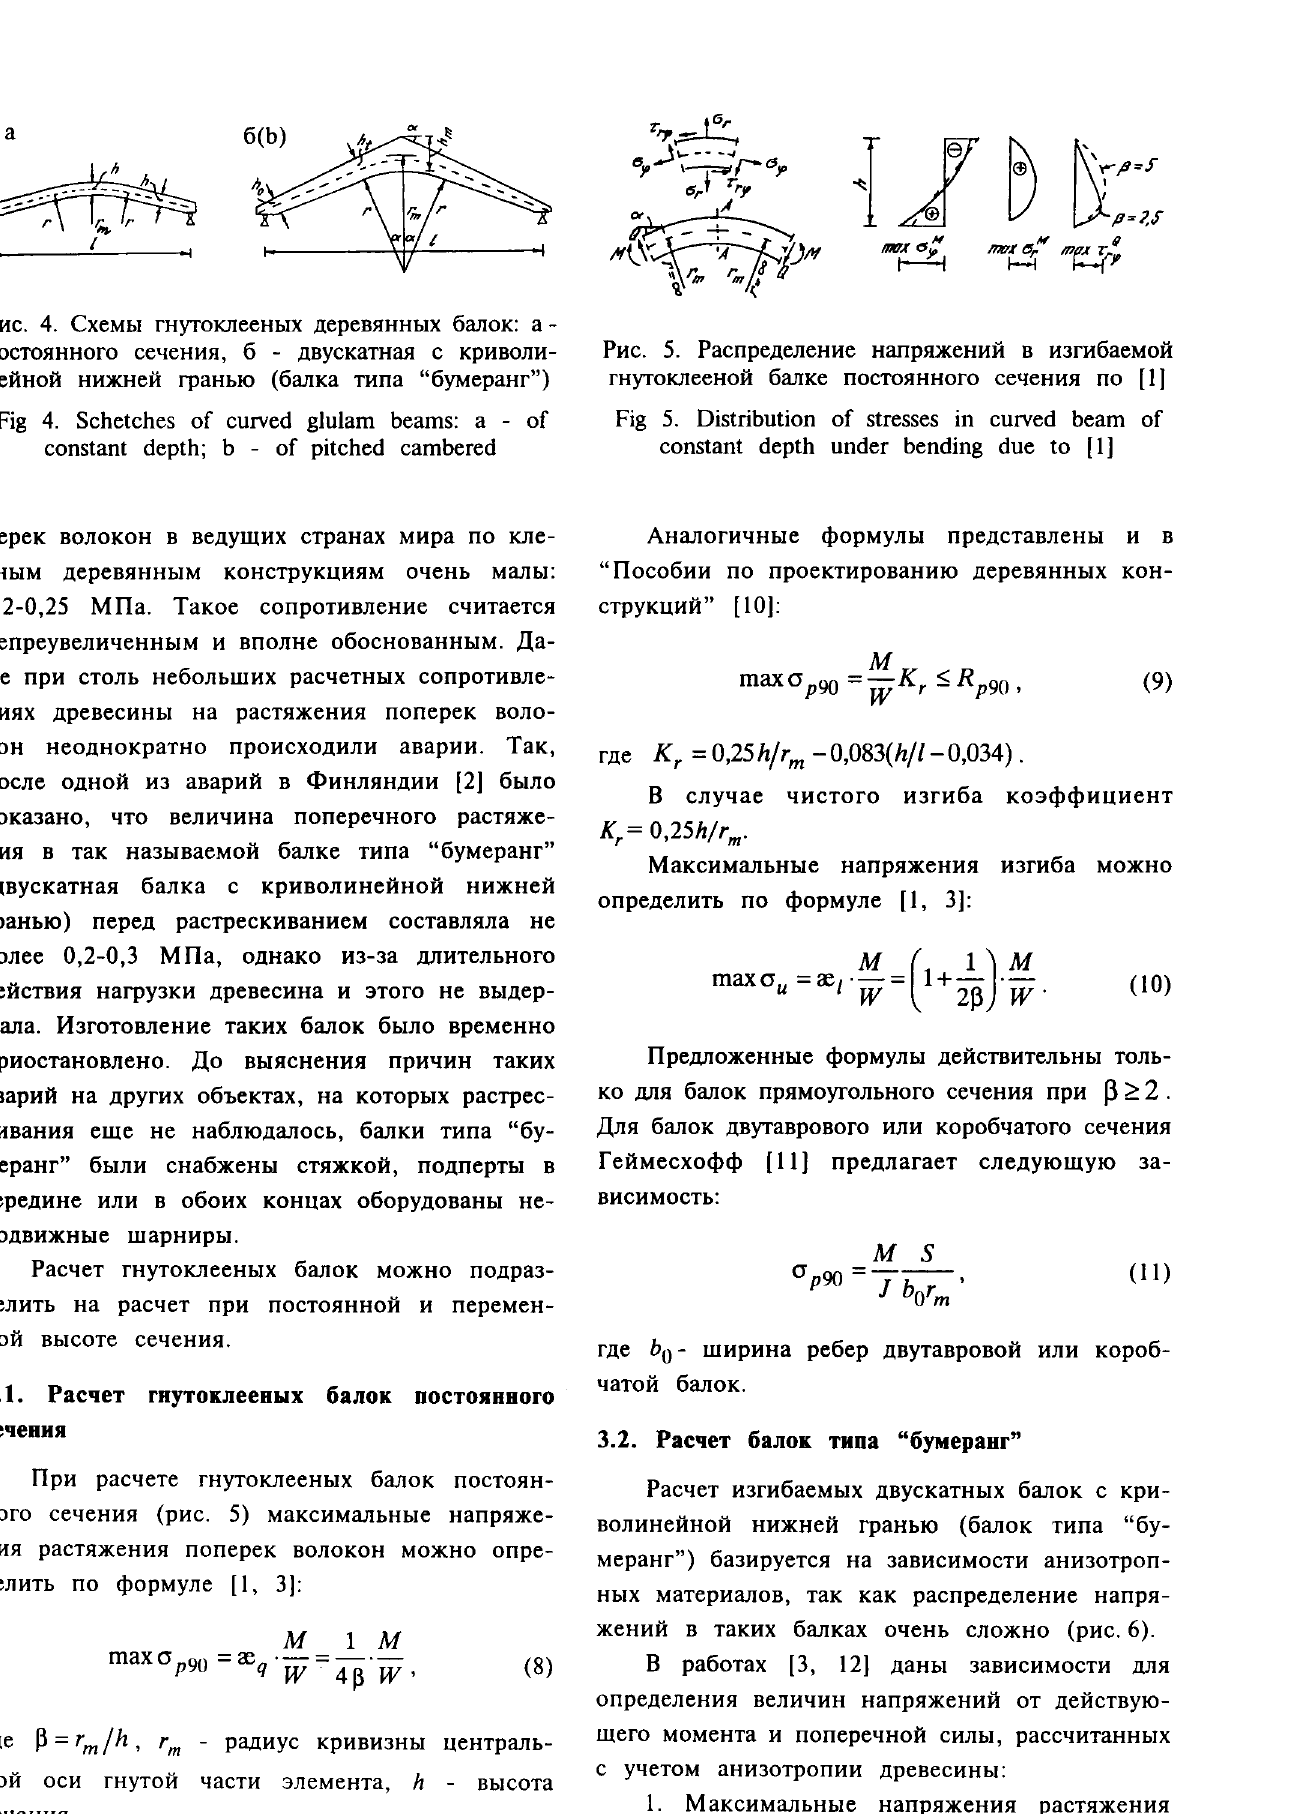
Fig 4. Schetches of curved glulam beams: a - of constant depth; b - of pitched cambered